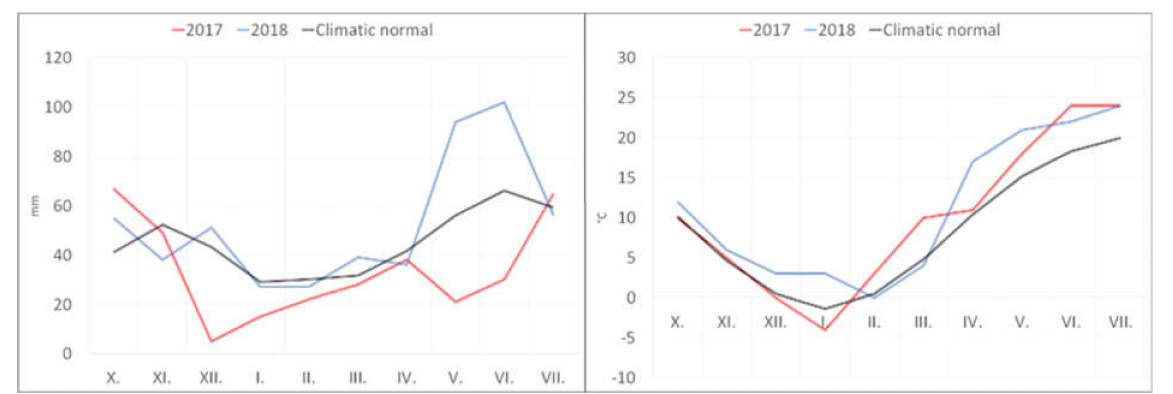
Figure 2. Precipitation (mm) and temperature ( ◦ C) variabilities of research years on experimental area. Included are long-term climatic normal values (1951–2000) of